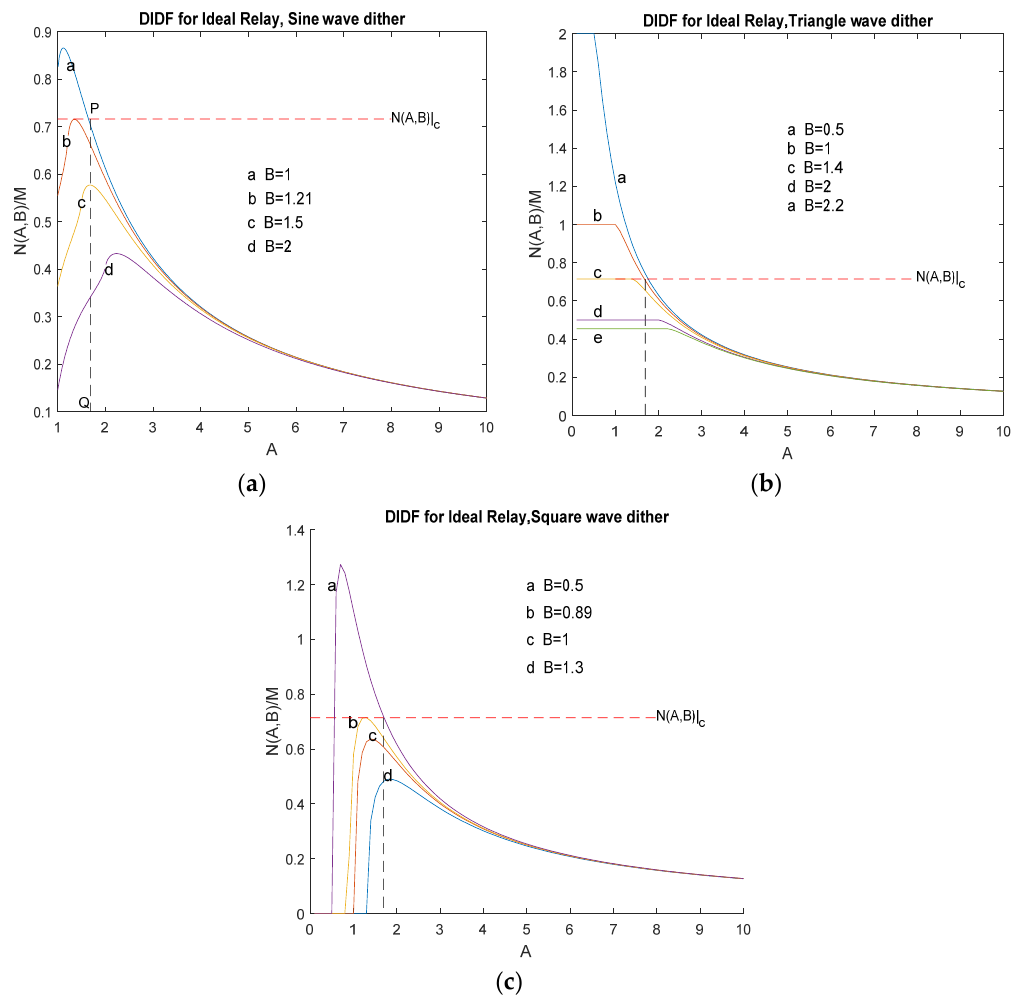
Figure 4. DIDF curve for Ideal Relay, ( a ) Sine wave dither, ( b ) Triangle wave dither, ( c ) Square wave dither.